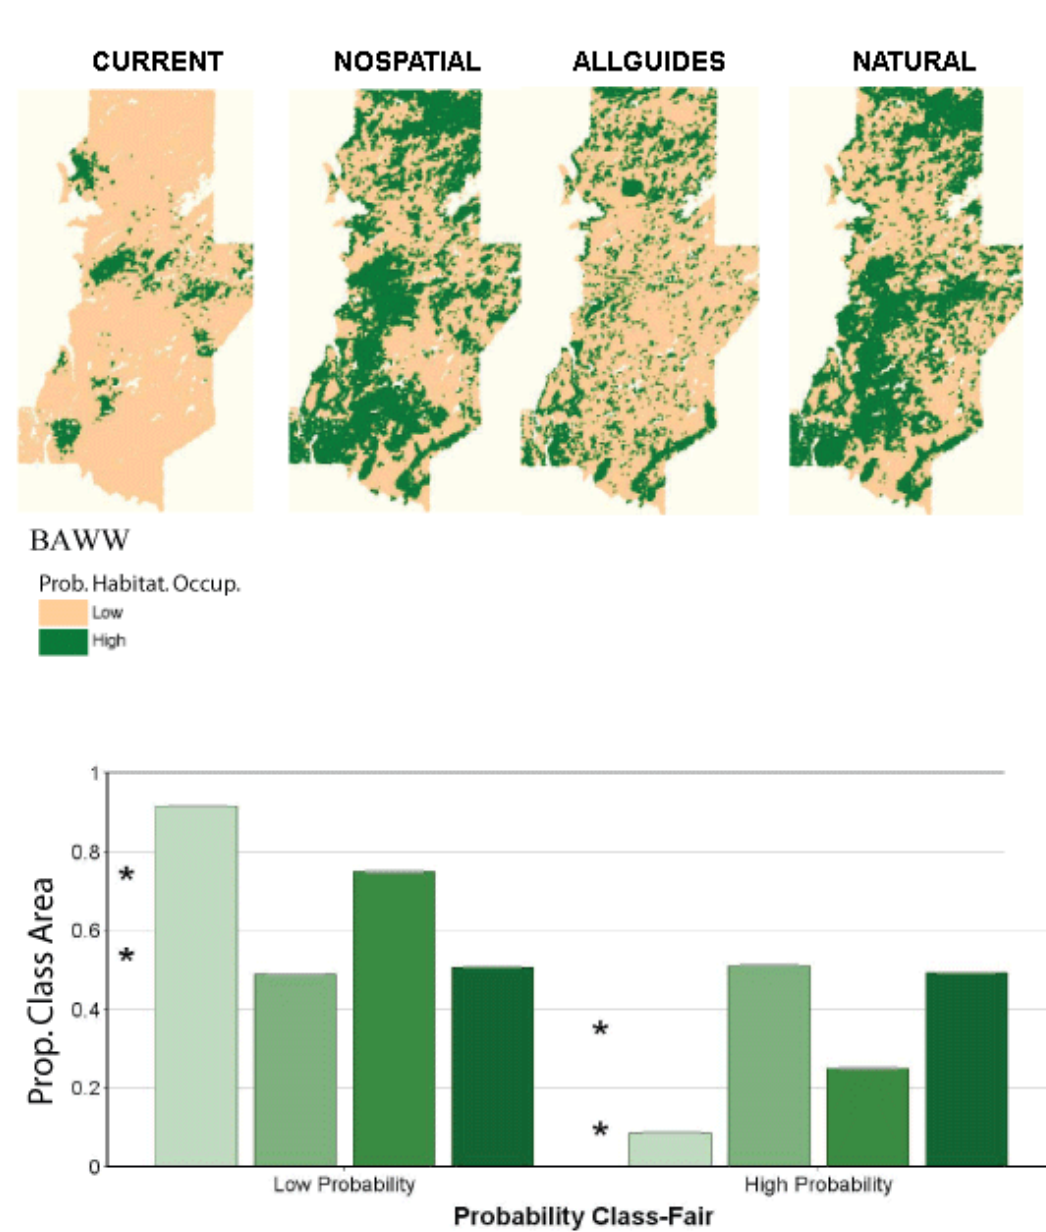
Fig. 11. Spatial pattern signatures for Black-and-white Warbler (BAWW) based on Patchworks projections (year 100) of four management scenarios (see Table 2 for definitions). Histograms depict proportion of map-area for low vs. high expected habitat occupancy for each of the four scenarios, and asterisks represent